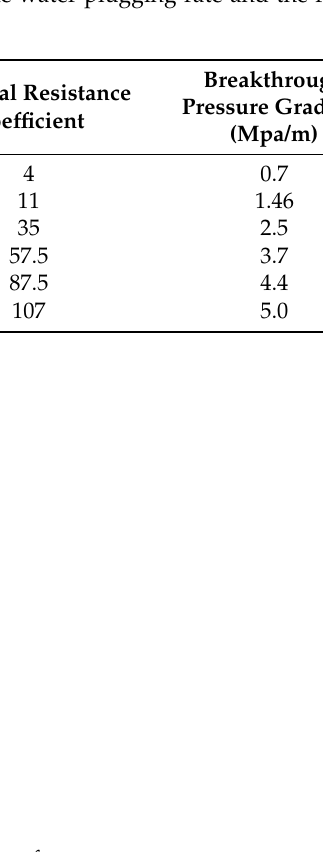
Figure 9. Effect of the frozen gel injection rate on plugging performance.